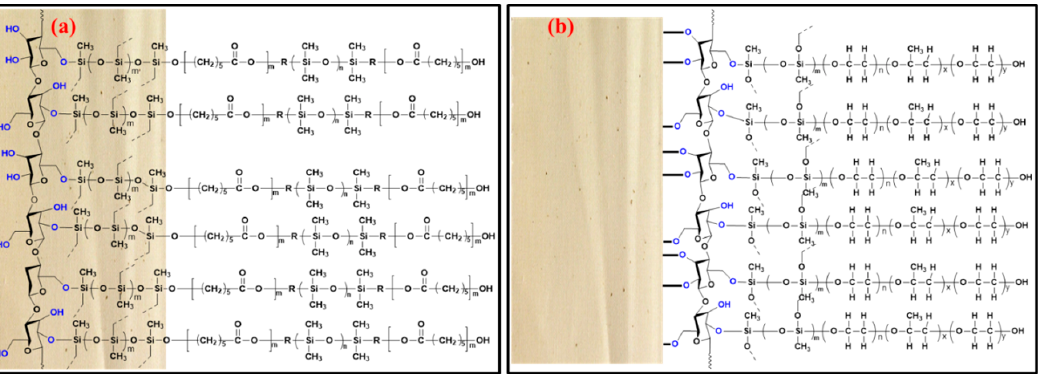
Figure 1. Schematic representation of ( a ) sol-gel PCAP-PDMS-PCAP; ( b ) sol-gel PEG-PPG-PEG coated FPSE media.